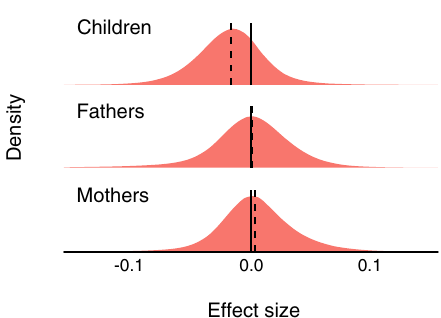
Fig. 2 Distribution of the differences in DNA methylation between ART conceived and naturally conceived. The effect sizes on the x-axis refer to the coef fi cients from the regression of DNA methylation at each CpG site on ART conceived versus naturally conceived, for newborns, fathers, and mothers. The vertical dashed line indicates the median value of the effect sizes. The adjusting variables for newborns were maternal age, maternal smoking, maternal BMI before pregnancy, child sex, parity, and plate ID. The adjusting variables for fathers were paternal age, paternal smoking, and paternal BMI. The adjusting variables for mothers were maternal age, maternal smoking, maternal BMI before pregnancy, and parity. Source data are provided as a Source Data fi